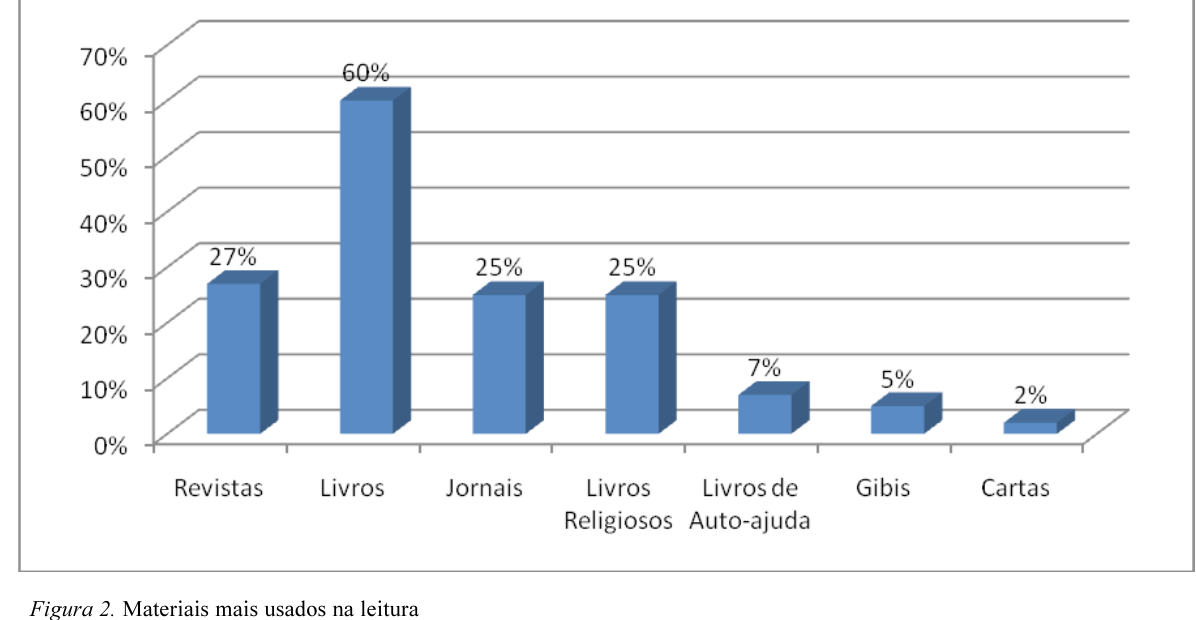
Figura 2. Materiais mais usados na leitura